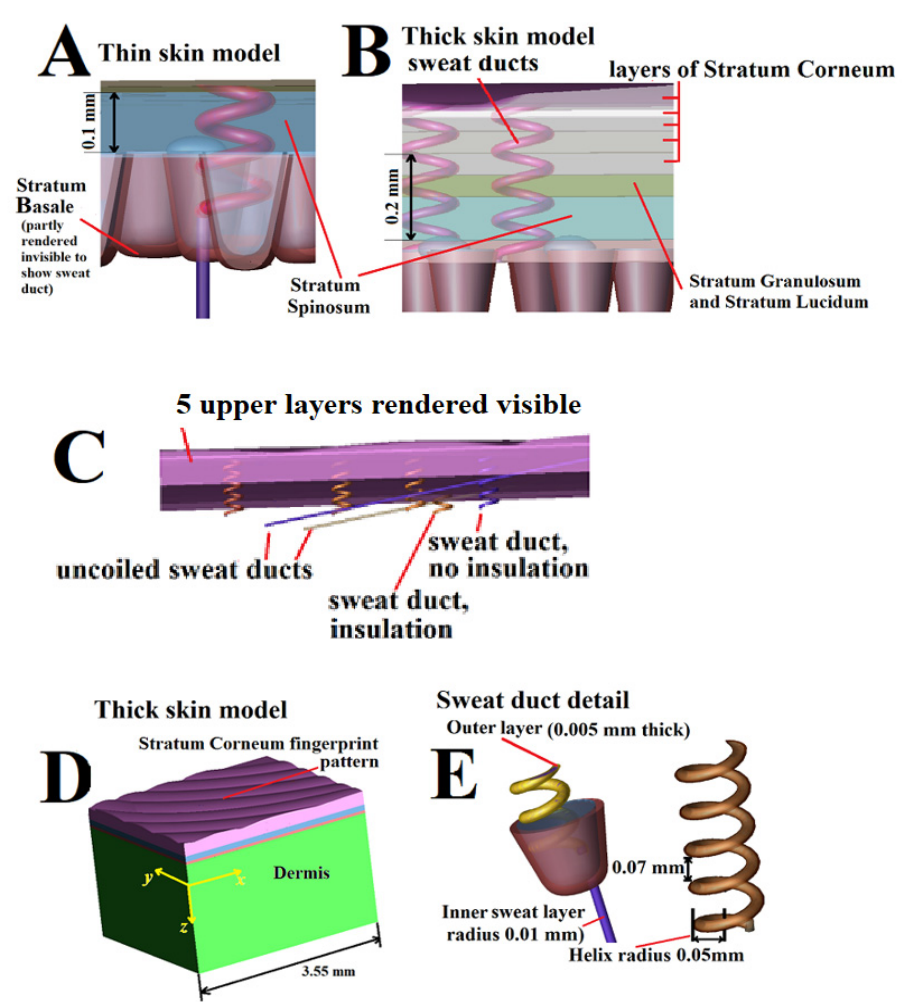
Figure 2. ( A ) The sweat duct within the XFdtd thin skin model, with 3 helical turns, chiefly within the stratum spinosum, positioned within the rete ridges to match anatomy. ( B ) Detail of the thick skin model, with the layers of the Stratum Corneum (gray), Stratum Granulosum and Strum Lu- cidum (green), Stratum Spinosum (blue), Stratum Basale and the rete ridges. ( C ) Multiple sweat ducts to be simulated concurrently each with distinct properties. The “uncoiled’ sweat ducts are illustrated. ( D ) Overview of the thick skin model with fingerprint pattern. ( E ) Sweat duct detail: an independently variable outer coat of 0.005 mm thickness and an inner duct radius of 0.01 mm.